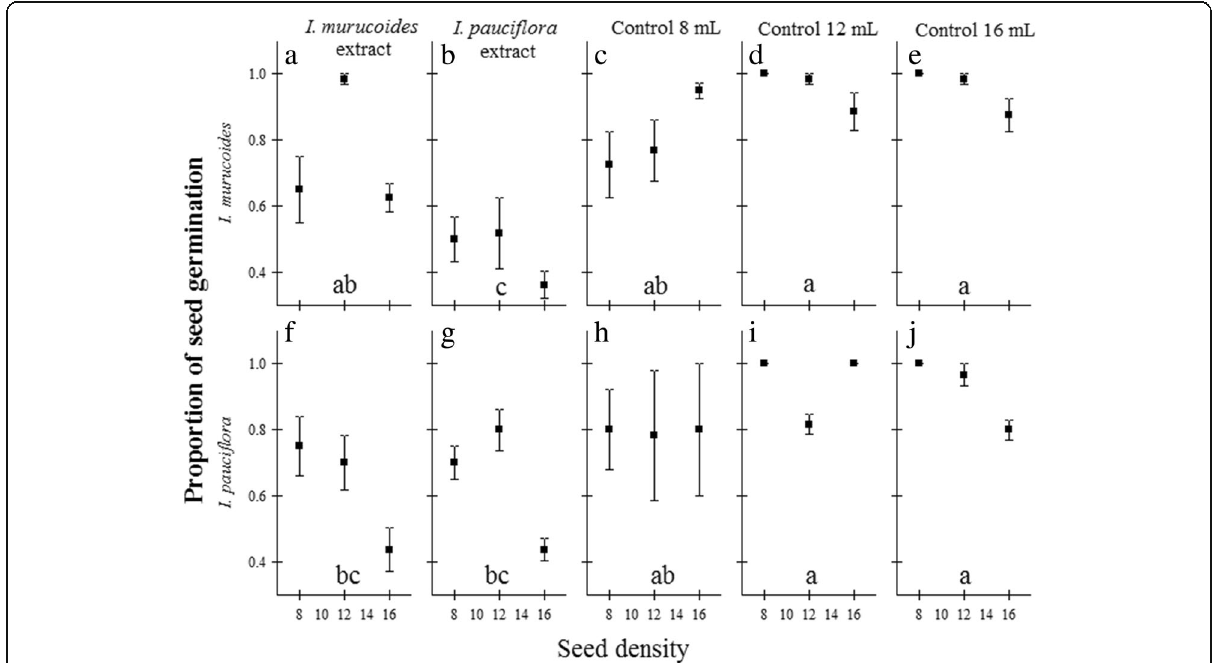
Fig. 2 Mean germination (± SE) of Ipomoea murucoides ( a - e ) and I . pauciflora seeds ( f - j ) in response to the addition of liquid extracts of I . murucoides and I . pauciflora and to sowing at three different densities. Different lowercase letters indicate differences statistically significant among type of aqueous extracts at P < 0.05 (Tukey test)